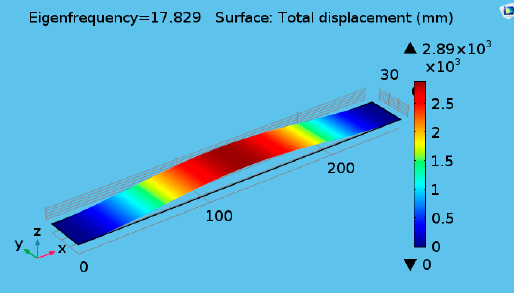
Figure 2. First mode response of the belt.